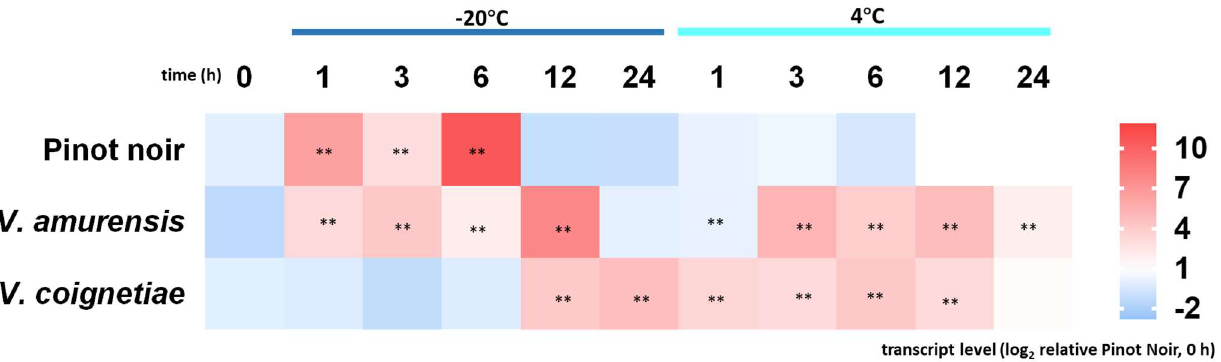
Figure 9. Time course for the response of transcripts for CBF4 to cold stress in fully expanded leaves from different Vitis genotypes. Plants of comparable developmental states were challenged by chilling (4 °C) and freezing (−20 °C). The leaves were sampled at the indicated time points after cold stress. Steady-state transcript levels are compared to the values found in Pinot Noir prior to cold stress. Data represent mean values from three biological replicates per each genotype and time point. Asterisks (**) represent statistically significant differences in the LSD test ( p < 0.01).